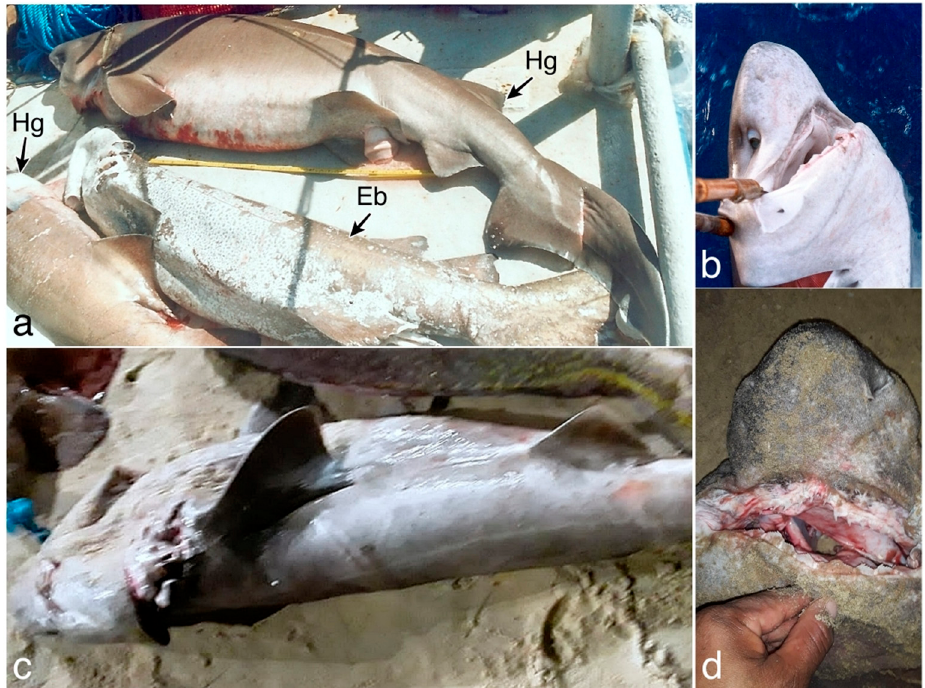
Figure 2. Female Hexanchus griseus specimen ( a ) caught off the state of Paraíba, Brazil, and ( b ) the specimen’s head during the landing and; and another female specimen ( c ) landed at the Mucuripe Embayment, in the state of Ceará, Brazil, photographed by the fishmonger with a ( d ) ventral view of the head. Hg, Hexanchus griseus ; Eb, Echinorhinus brucus .